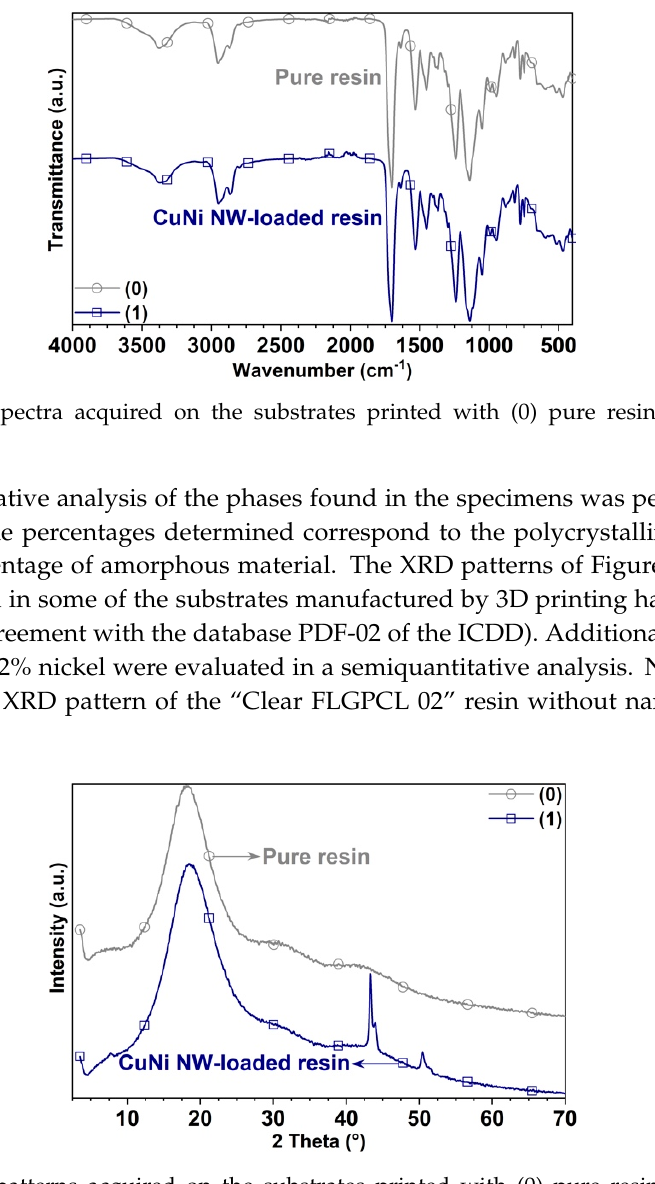
Figure 9. FTIR spectra acquired on the substrates printed with (0) pure resin and (1) CuNi NW-loaded resin.